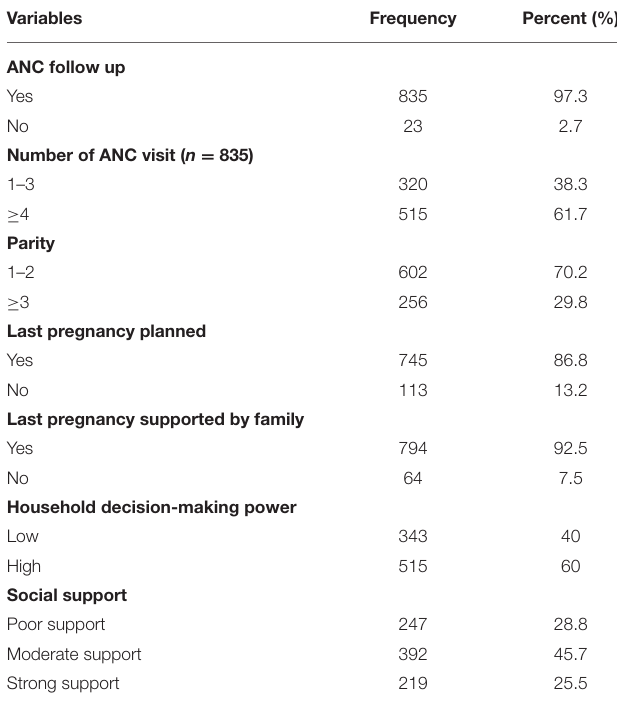
TABLE 2 | Reproductive and maternity health service characteristics of the study participants in Gondar city, ( n =